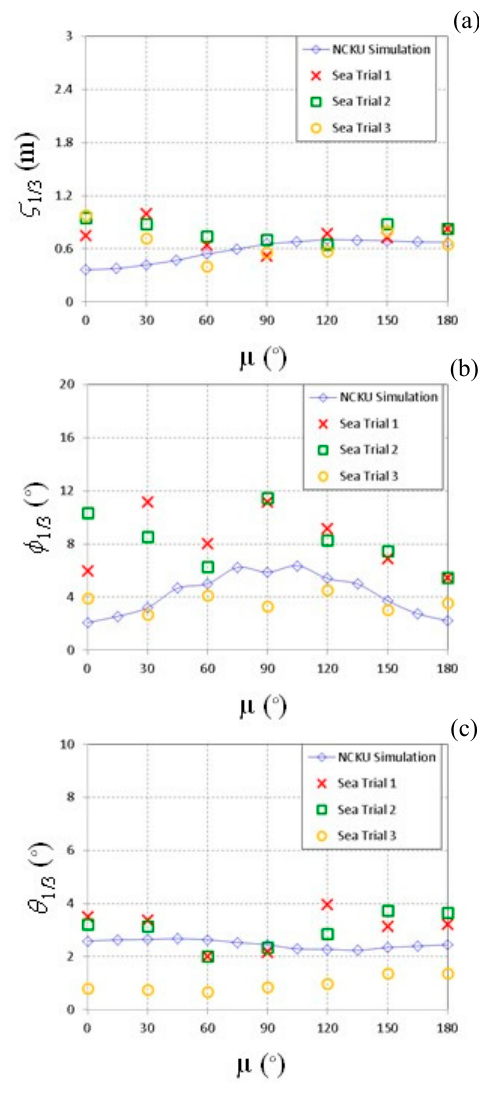
Figure 5. Comparison of results for the simulation and on-board measurement in terms of ( a ) heaving, ( b ) rolling, and ( c ) pitching motion at high sailing speed.